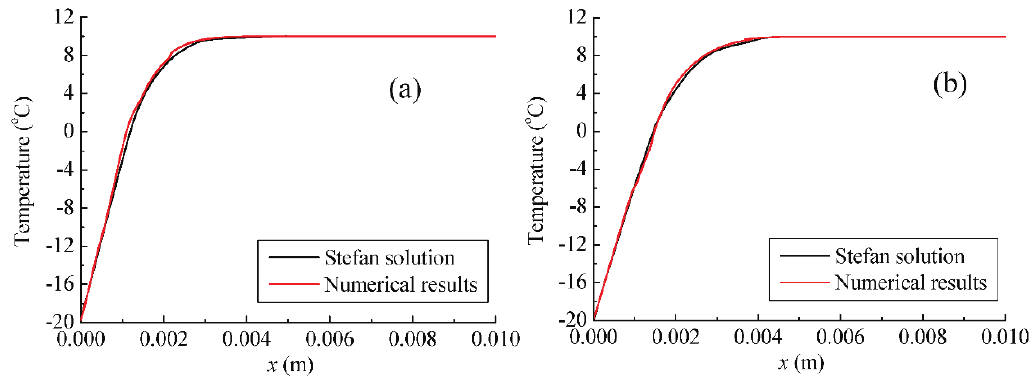
Figure 6. Distribution of temperature by theoretical solution and current method ( a ) 6 s and ( b ) 9 s.